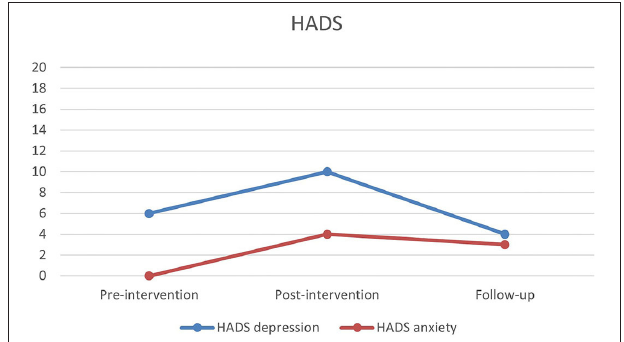
FIGURE 1 | Pre-, post- and follow-up scores on Hospital Anxiety and Depression Scale